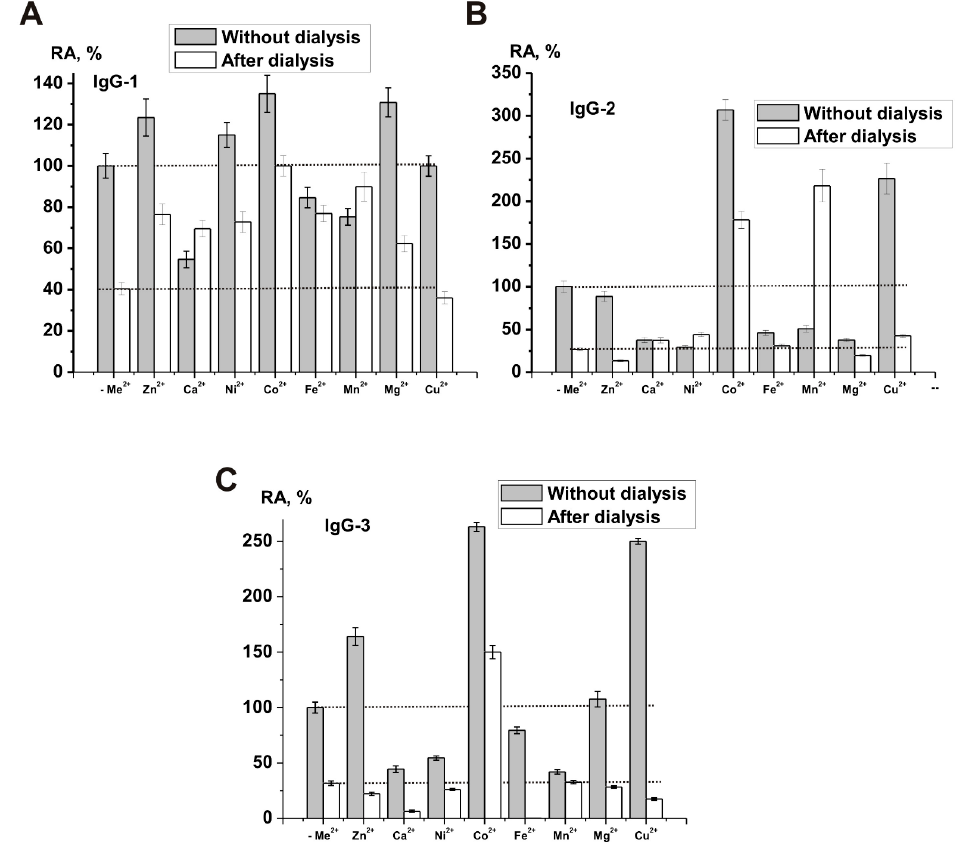
Figure 1. Effect of the dialysis of three individual IgG preparations from sera of schizophrenic patients against EDTA and different external metal ions on the relative activity (RA, %) of dialyzed and non-dialyzed preparations ( A – C ). The relative activity of every non-dialyzed preparation was taken for 100%. All IgGs and metal ions used are marked on Panels A–D [161]. In contrast to canonical catalases, Co 2+ ions increased the reaction rate better than any other metal ions, while the effect of Cu 2+ , Mn 2+ , Ni 2+ , and Fe 2+ ions on the activity of abzymes was weak or absent altogether. Each of the polyclonal IgG preparations exhibited several distinct pH optima ranging from 4.0 to 9.5. Figure 2 shows the pH dependence